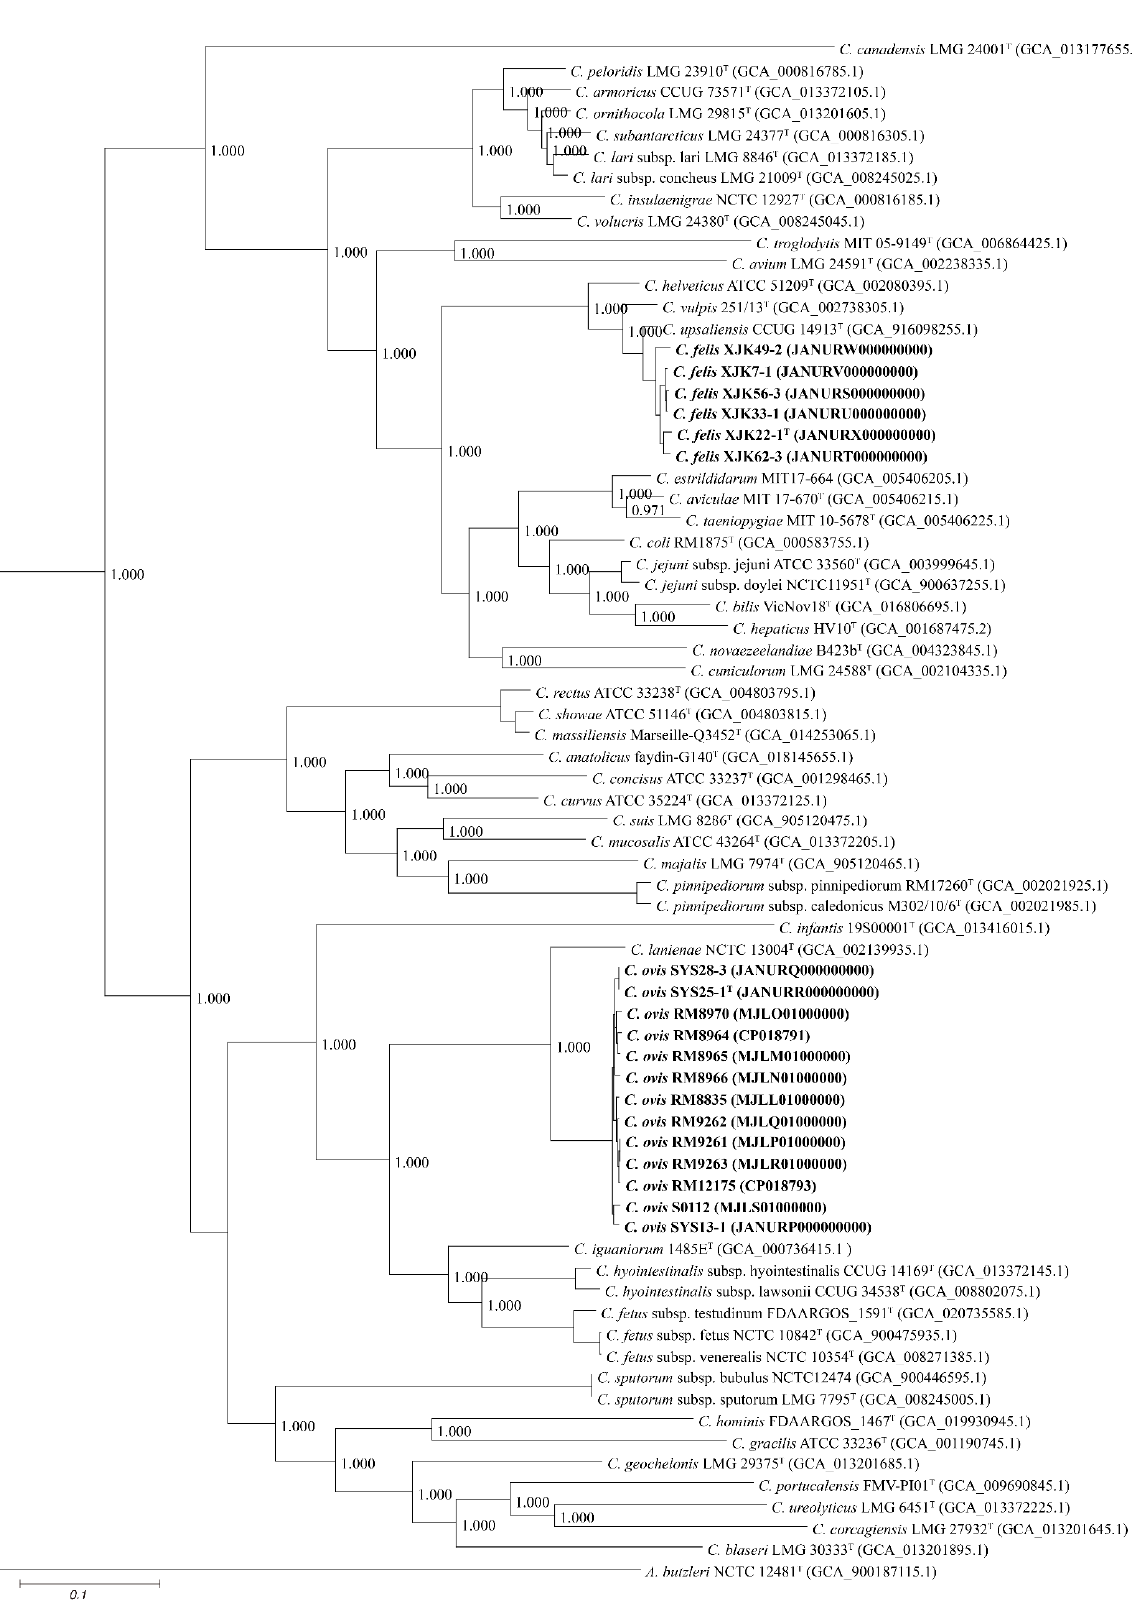
Figure 3. Neighbor-joining phylogenomic tree based on 332 core genes of the genus Campylobacter . The outgroup is Arcobacter butzleri ATCC 49616 T . Novel strains are highlighted in